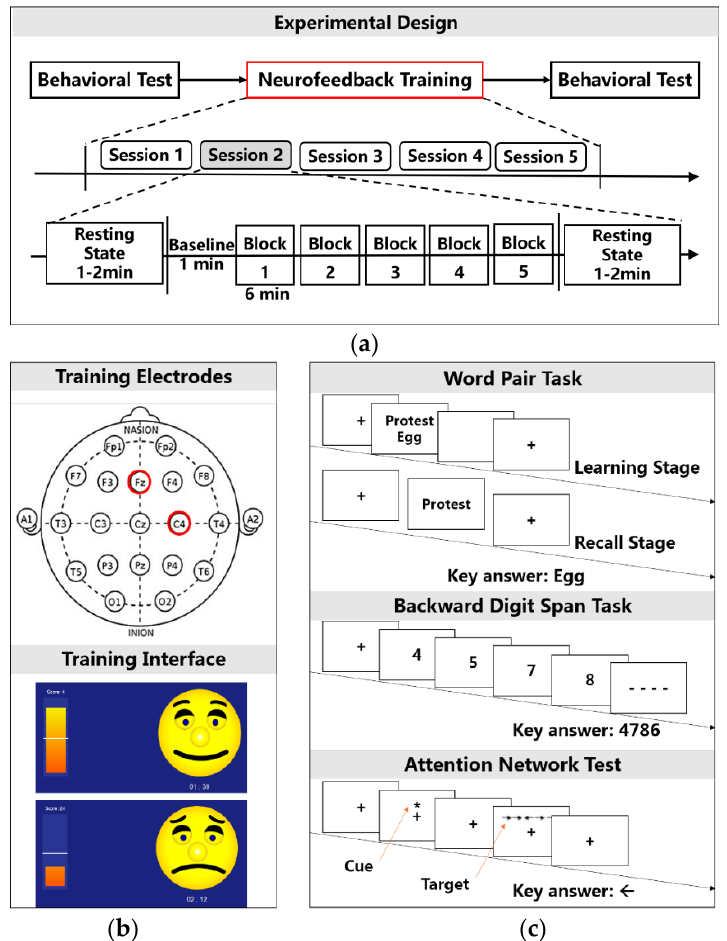
Figure 2. Flow diagram of the experiment for subjects. ( a ) Experimental design includes the behavioral test and neurofeedback training that covered five training sessions. There were six blocks that hold six minutes for each one in a session; ( b ) The neurofeedback protocol adopts Fz and C4 as training electrodes and the “face” dynamic picture as the training interface; ( c ) Behavioral tests include word pair task, backward digit span task and attention network